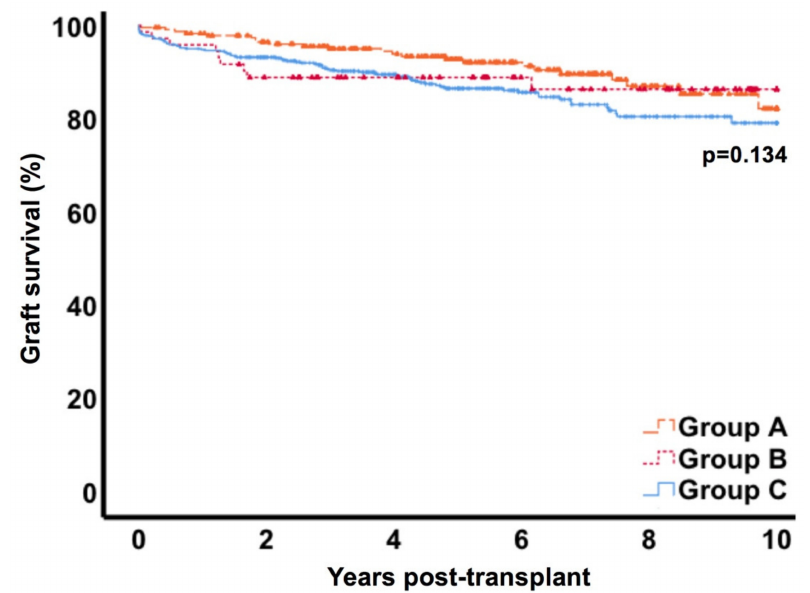
Figure 5. Death censored graft survival. * Group A = lymphocele conservatively monitored; Group B = lymphocele with intervention; Group C =